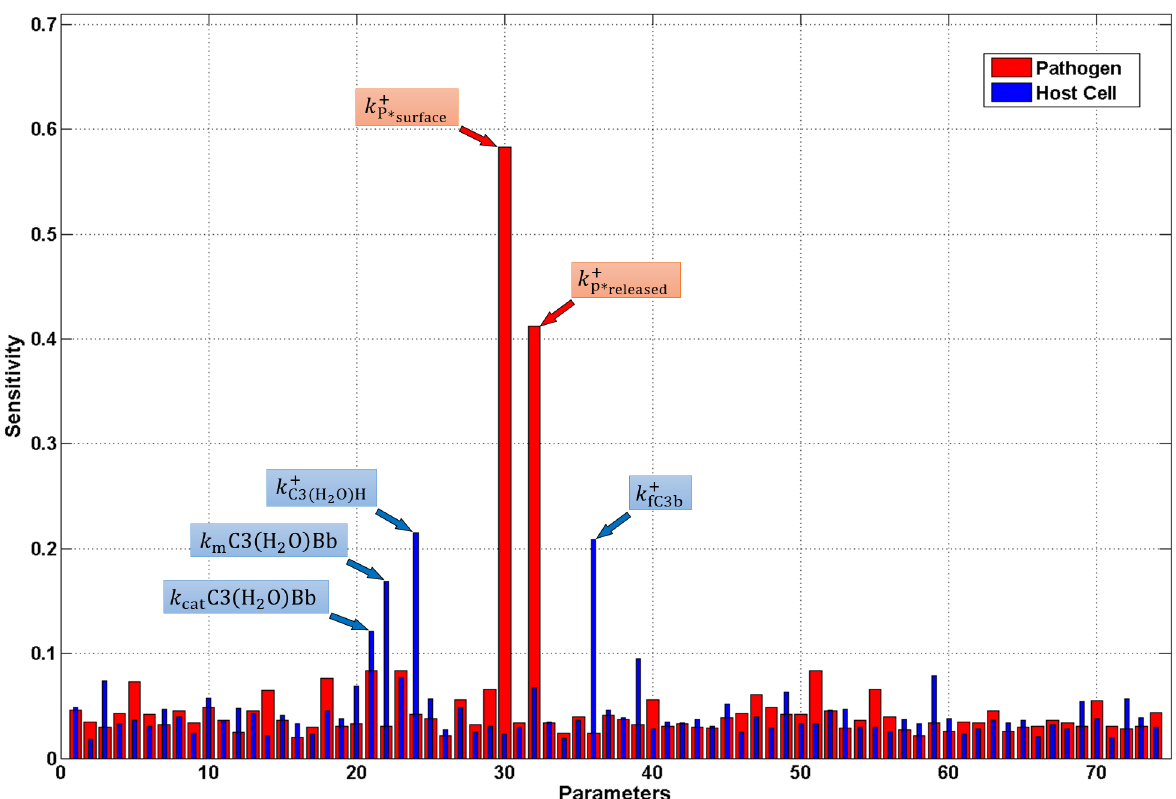
Fig 10. Results of multi-parametric sensitivity analysis to kinetic parameter values. The most sensitive rates on the surface of pathogens (red) are k þ k þ P (cid:1) surface , and p (cid:1) released , which represent the rate at which properdin associates to the surface and the rate at which it is released from neutrophils, respectively. While most kinetic parameter are mildly sensitive on host cells (blue), k þ C 3 ð H and k þ fC 3 b , which represent association of Factor H to hydrolyzed C3 and 2 O Þ conversion rate of nfC3b to fC3b, respectively, are more sensitive to parameter variations. The Michaelis – Menten kinetic parameters, k cat and K m of the fl uid phase convertase C3(H 2 O)Bb are also